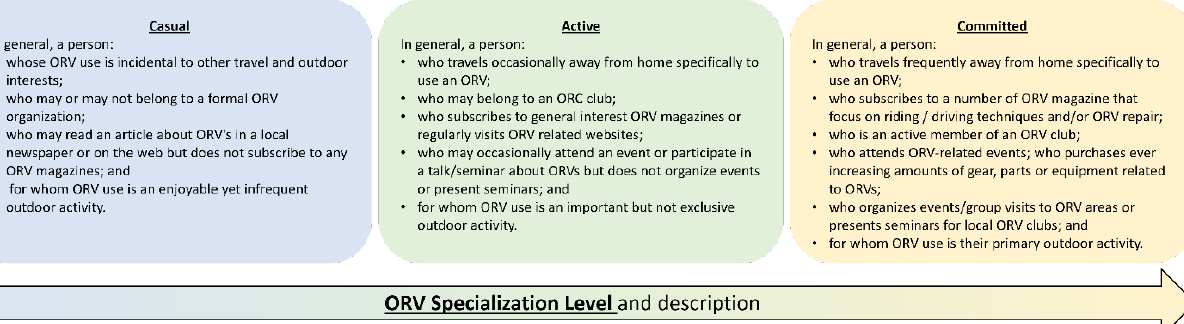
Figure 3. Recreation specialization levels of ORV users utilized, with descriptions presented to respondents for self-selection of single specialization level. respondents for self-selection of single specialization